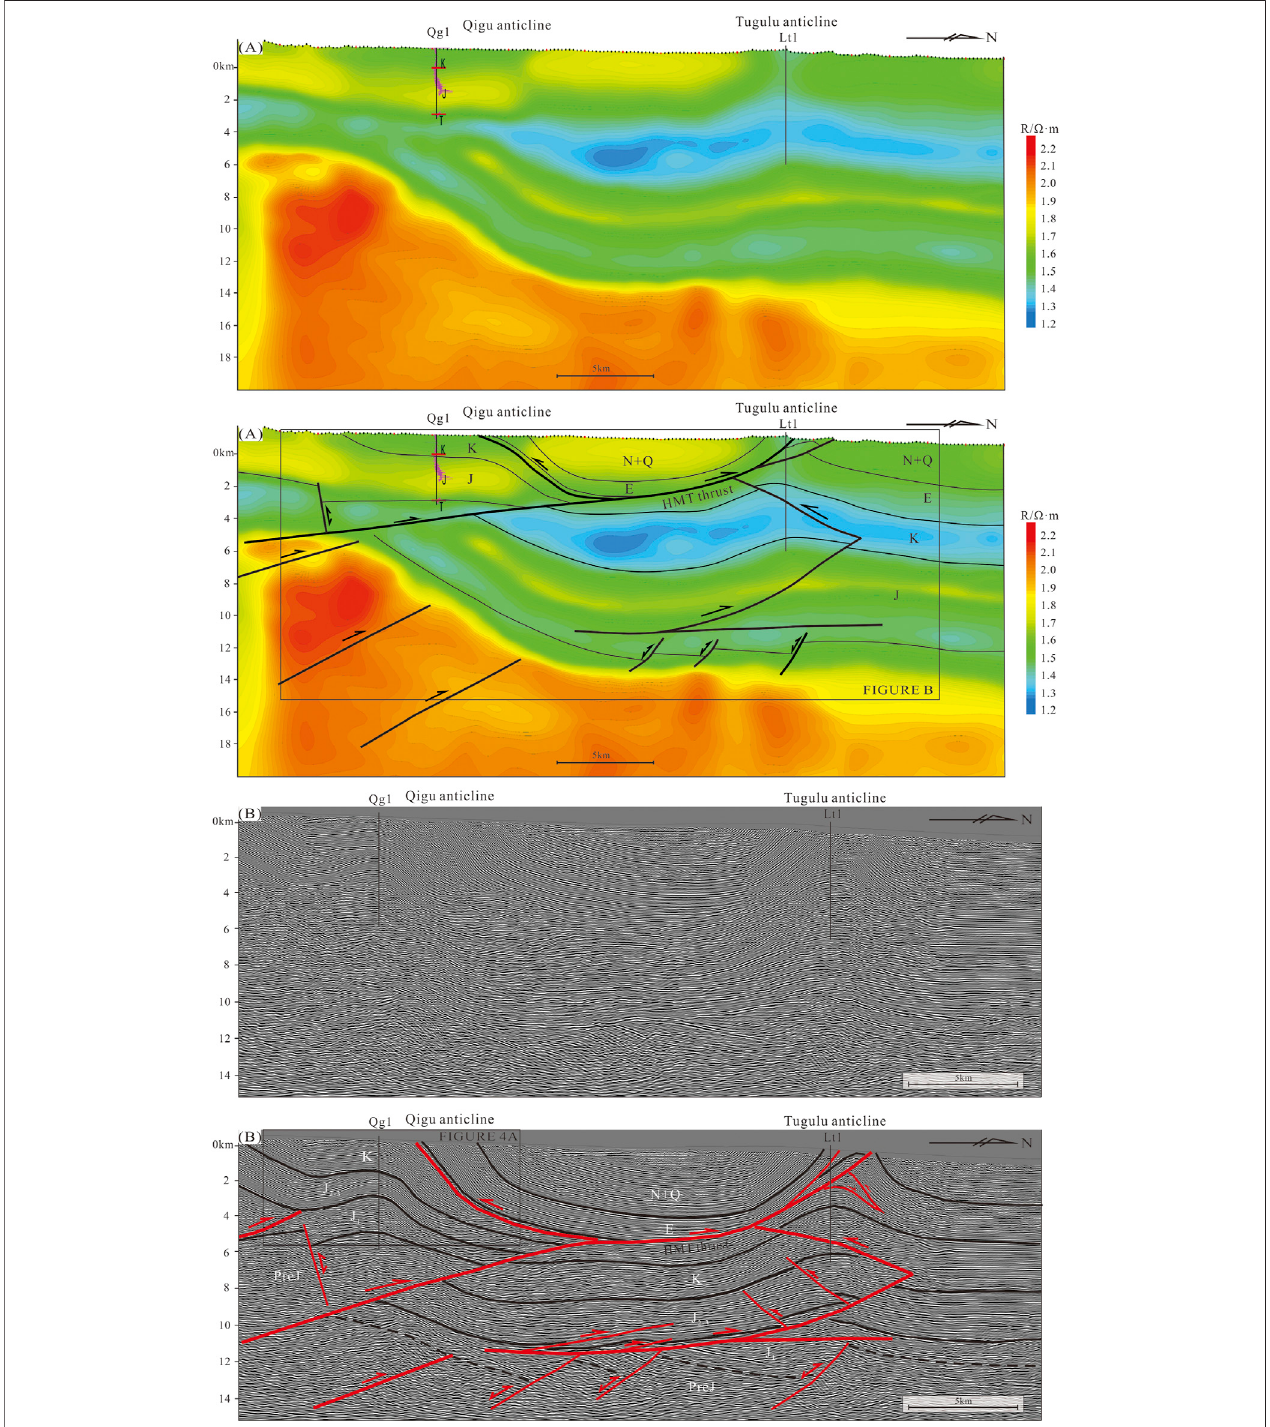
FIGURE3| SectionscuttingacrosstheQiguandTuguluanticlines(forlocationsee Figure1C ),showingtheshallowfoldsandthrustsdetachedabovethewedge- shaped Lower Jurassic strata. Note the wedge-shaped nature of the Lower Jurassic strata indicating the syn-kinematic deposition. (A) : Regional transient electromagnetic section. (B) : Seismic re fl ection section.